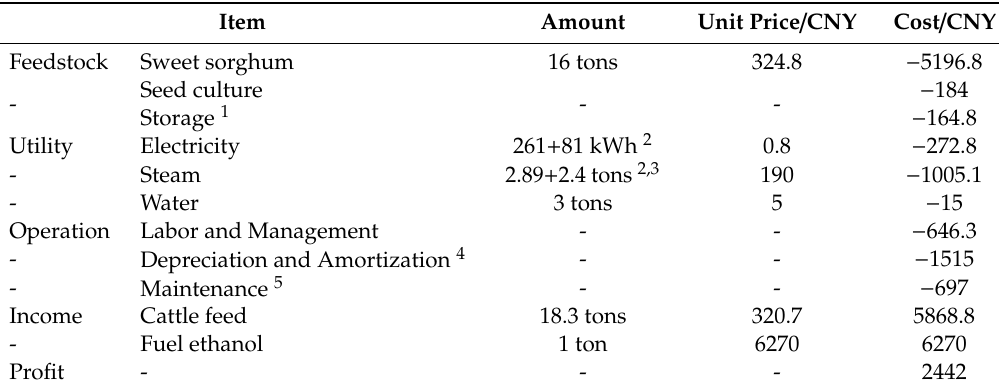
Table 6. Economic analysis of 1 ton 99.5% fuel ethanol with ASSF and CSSD